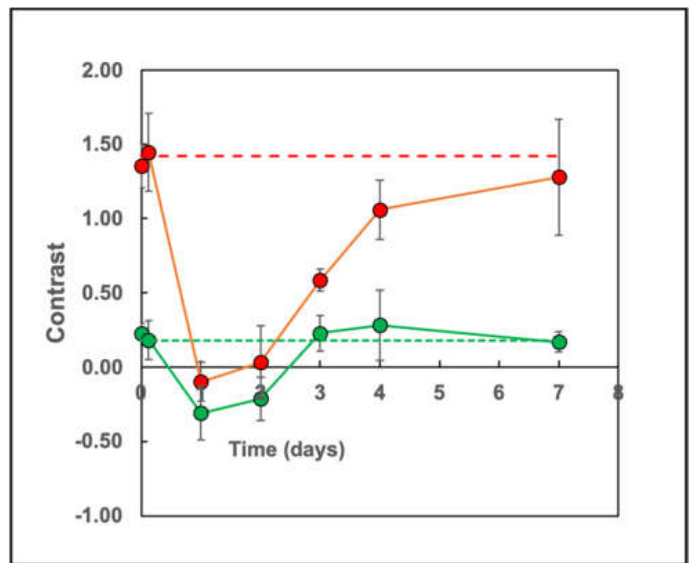
Figure 6. Time course of the SPION-induced contrast in T 1 w (TR = 550, TE = 14 ms) and T 2 w (TR = 2500 ms, TE = 50 ms) MR images of EF43. fgf4 murine breast tumors. The red curve shows the tumor/muscle contrast (C 2 ) measured from T 2 w images, while the green curve shows the tumor/muscle contrast (C 1 ) measured from T 1 w images in the same animals. The red and green dotted lines are drawn to show the control, pre-injection contrast values. Note how the contrast initially decreases and then returns to the pre-injection values by 7 days. The data points are measurements from eight slices each of 2 mice.